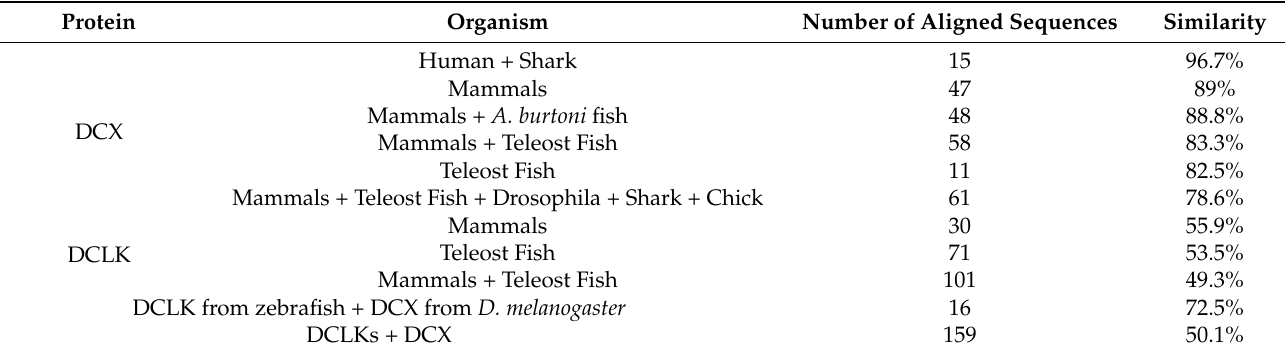
Table 2. Sequence similarities between selected proteins containing DCX1 and DCX2 domains. Comparison of entire DCX and/or DCLK amino acid sequences to assess protein conservation between different